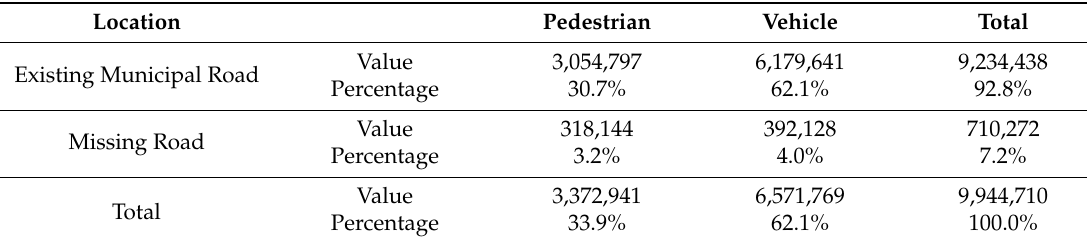
Table 3. Components of the case data.